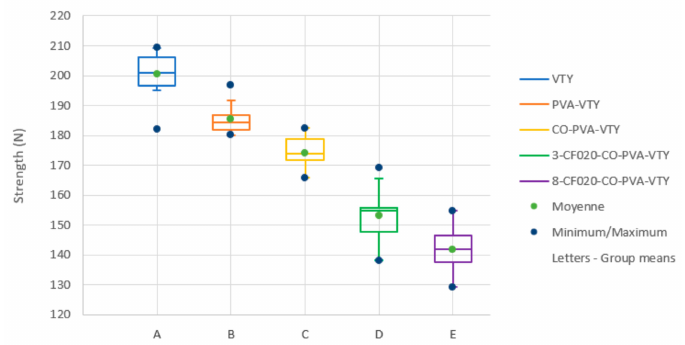
Figure 9. Box-plots of strength for each step allowing the realisation of sensor yarns. Letters A, B, C, D, and E on box-plot diagrams are the result of ANOVA analyses (Fisher’s test). NB: sample with different letters are scientifically